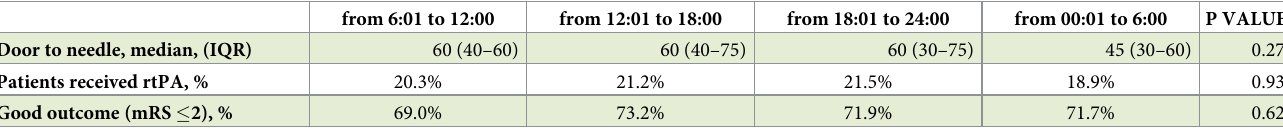
Table 3. Characteristics of patients according to time of first hospital